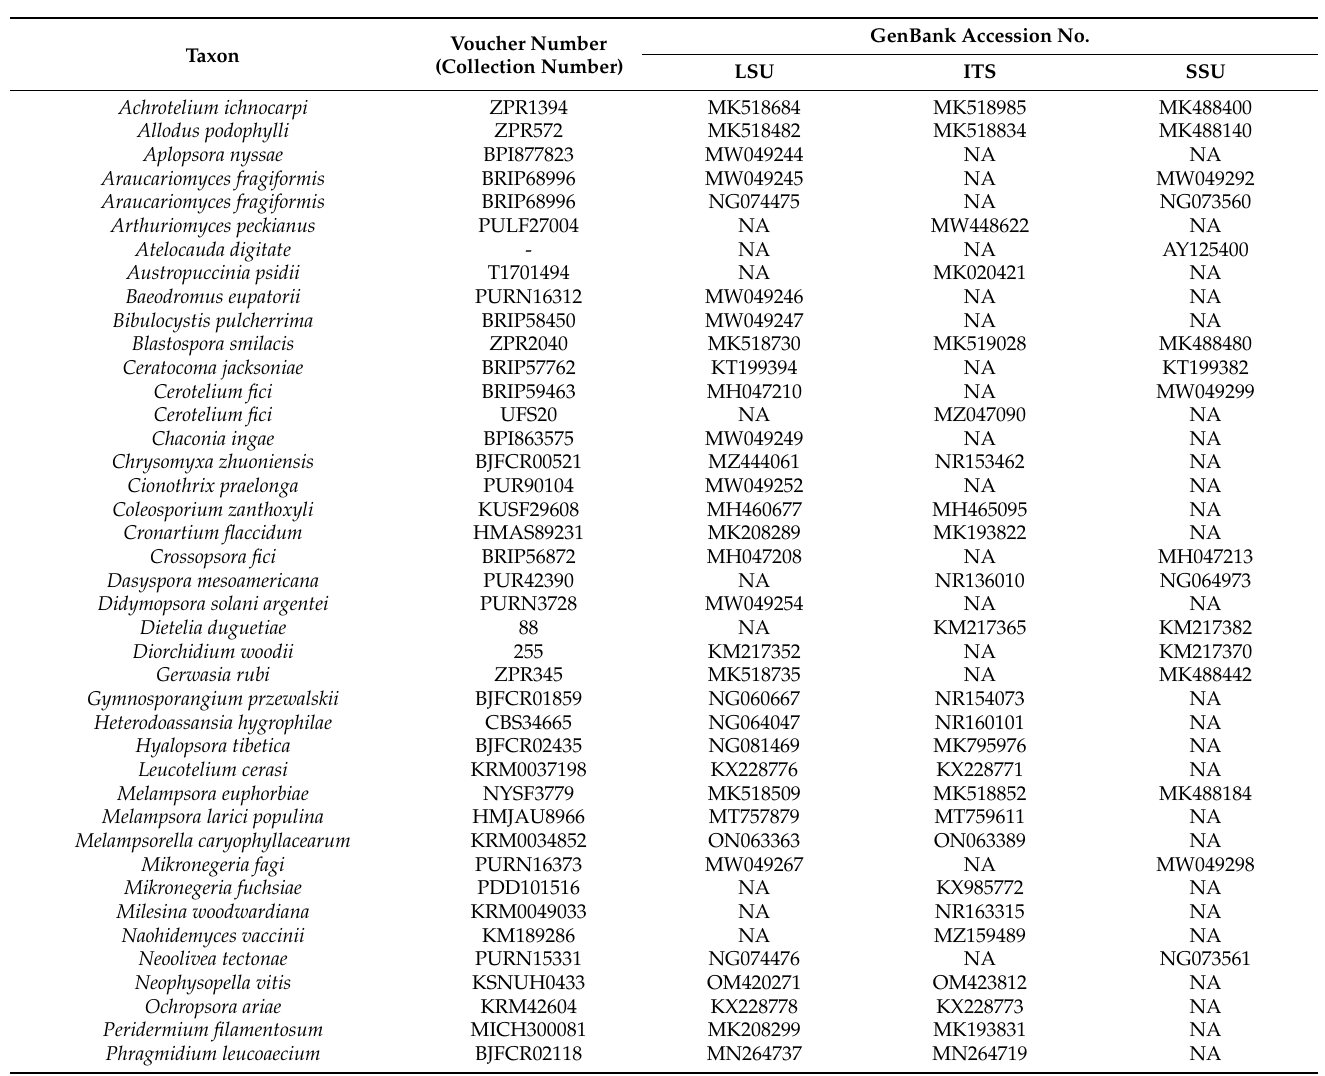
Table 3. GenBank and voucher or culture collection accession numbers of rust fungal species were included in the phylogenetic